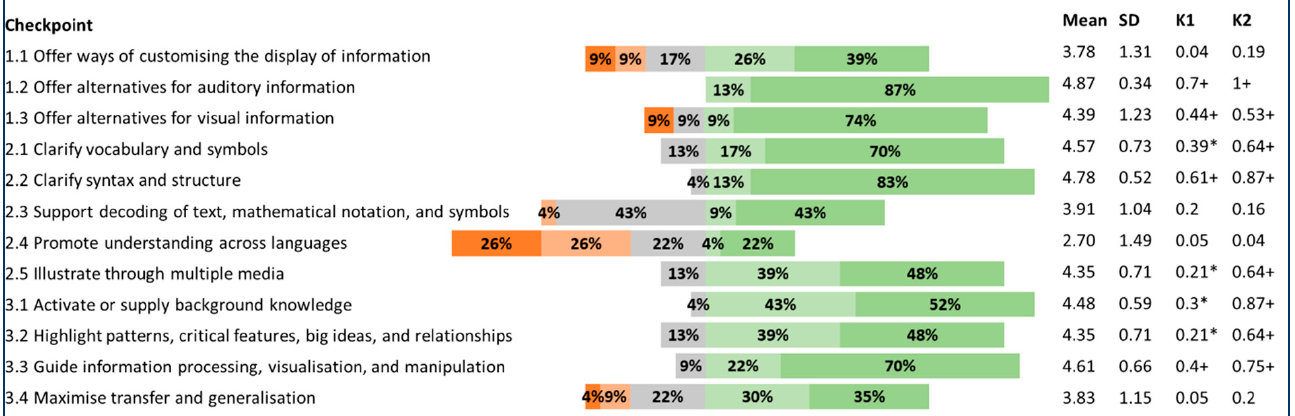
Figure 4. “Provide multiple means of representation” evaluation results. Note: standard deviation (SD), Kappa for 5 values (K1); Kappa for 3 values (K2); fair agreement *; moderate, substantial, and perfect agreements +.